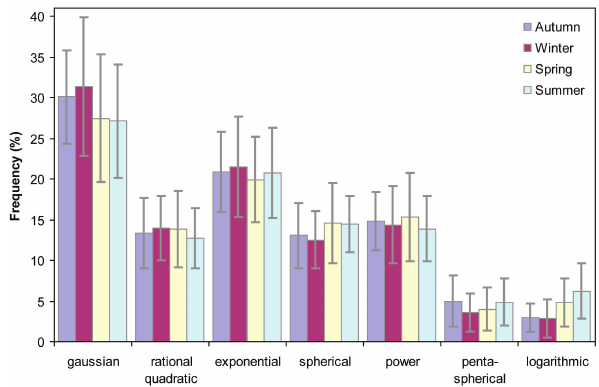
Fig. 7. Annual mean rainfall of the Ourthe and Ambleve catch- ments, generated using six different algorithms and 70 raingages available in and surrounding the two